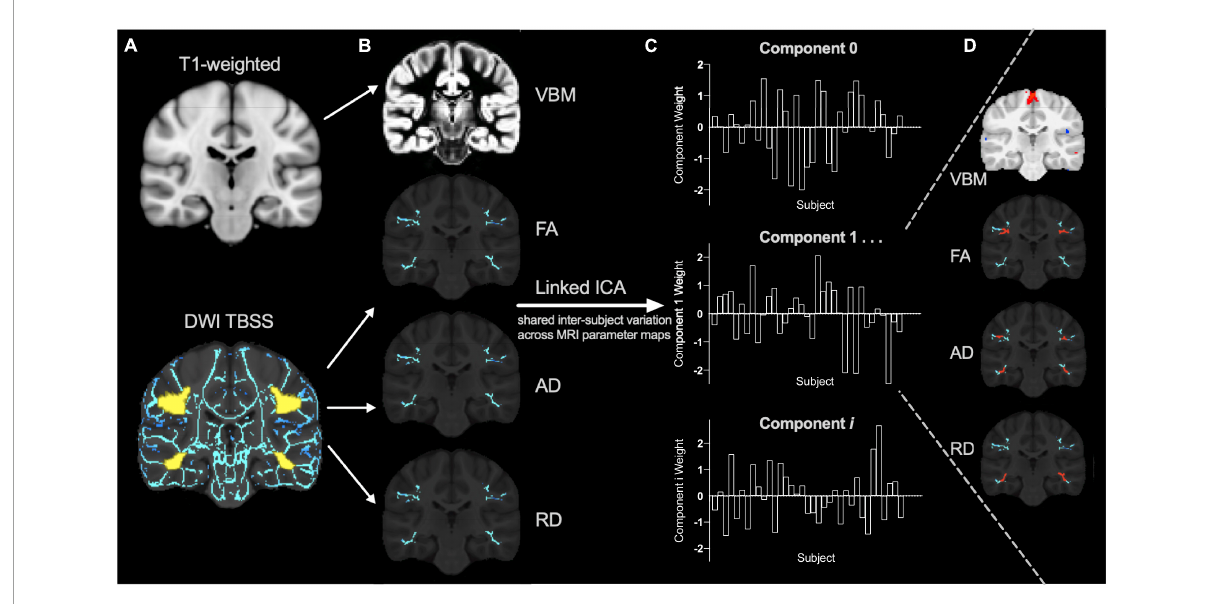
FIGURE1 Linked independent component analysis pipeline. (A) Preprocessed T1 and diffusion weighted images (DWI) were processed using voxel-based morphometry (VBM) and tract-based spatial statistics (TBSS) pipelines (with the reading-related tracts mask shown in yellow) to create (B) individual VBM, fractional anisotropy (FA), axial diffusivity (AD), and radial diffusivity (RD) spatial maps for each subject as input for the linked independent component analysis (ICA). The data is decomposed into a series of linked components comprised of (C) component weights that reflect the inter-subject variation shared across (D) all input measures (VBM, FA, AD, and RD) in specific brain regions (for example, shown in